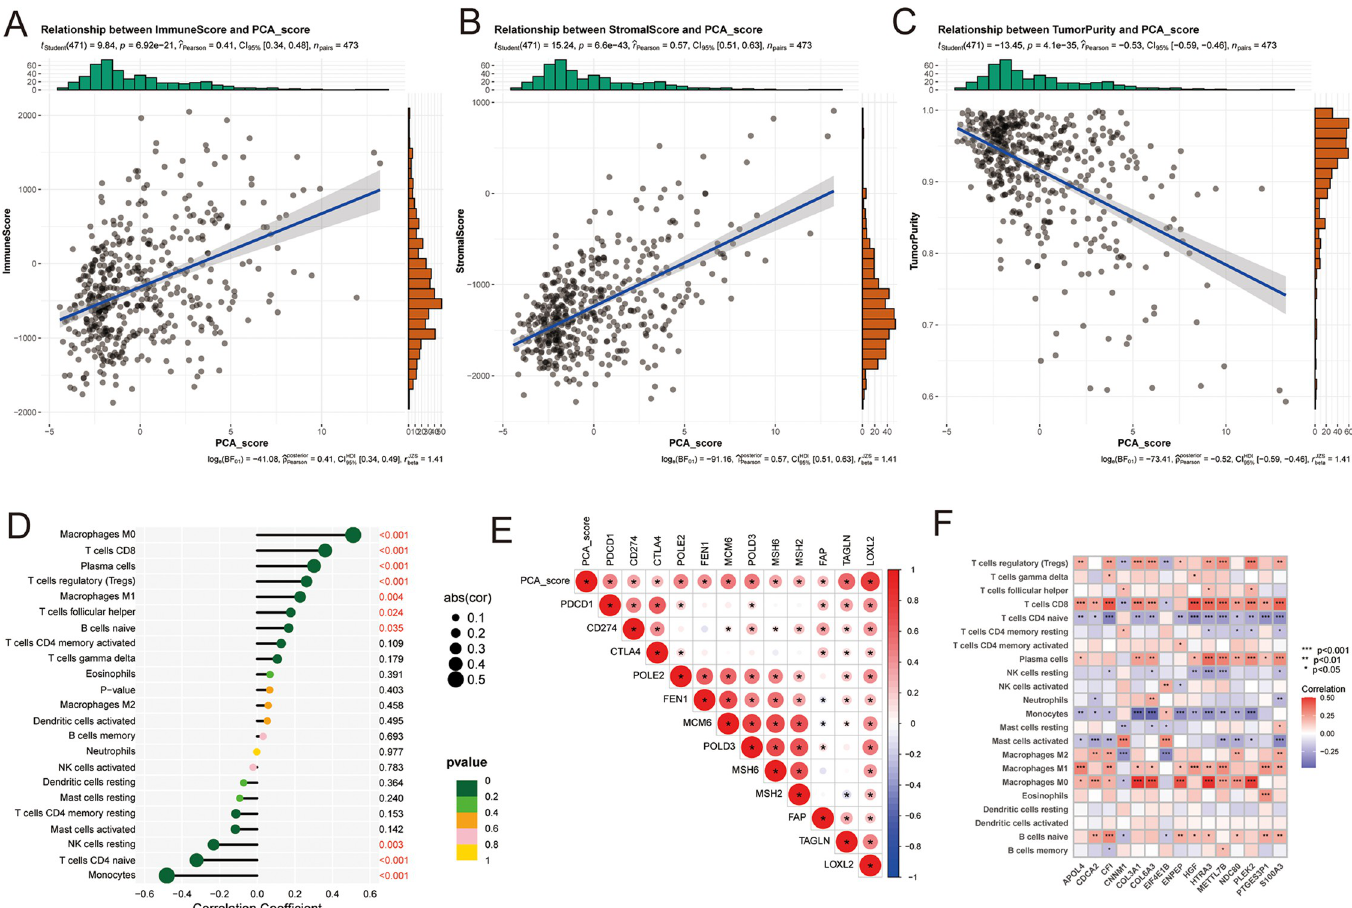
Fig 6. Comprehensive analysis of PCA_score with TME in LGG patients. Correlations between PCA_score and both immune score(A), stromal score(B) and tumor purity(C). (D) Correlations between PCA_score and immune cell infiltration abundance. (E) Correlation analysis between PCA_score and immune checkpoint genes. (F) Correlations between the abundance of immune cells and 15 genes in the proposed